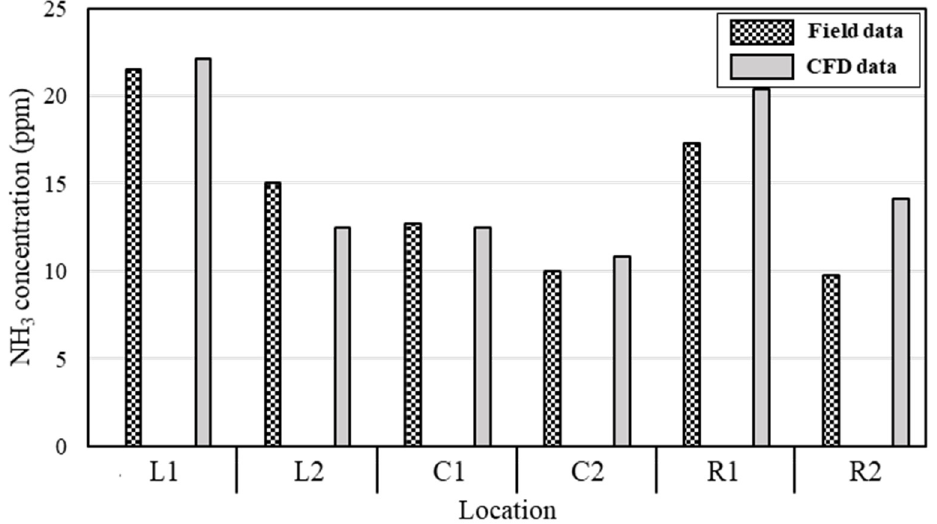
Figure 13. Ammonia concentration data of measurement and CFD computed results for each location inside the experimental piglet house .